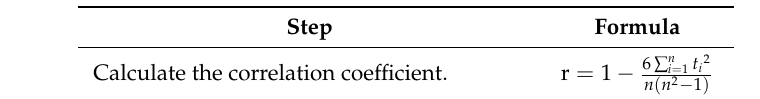
Table A6. The step and formula of